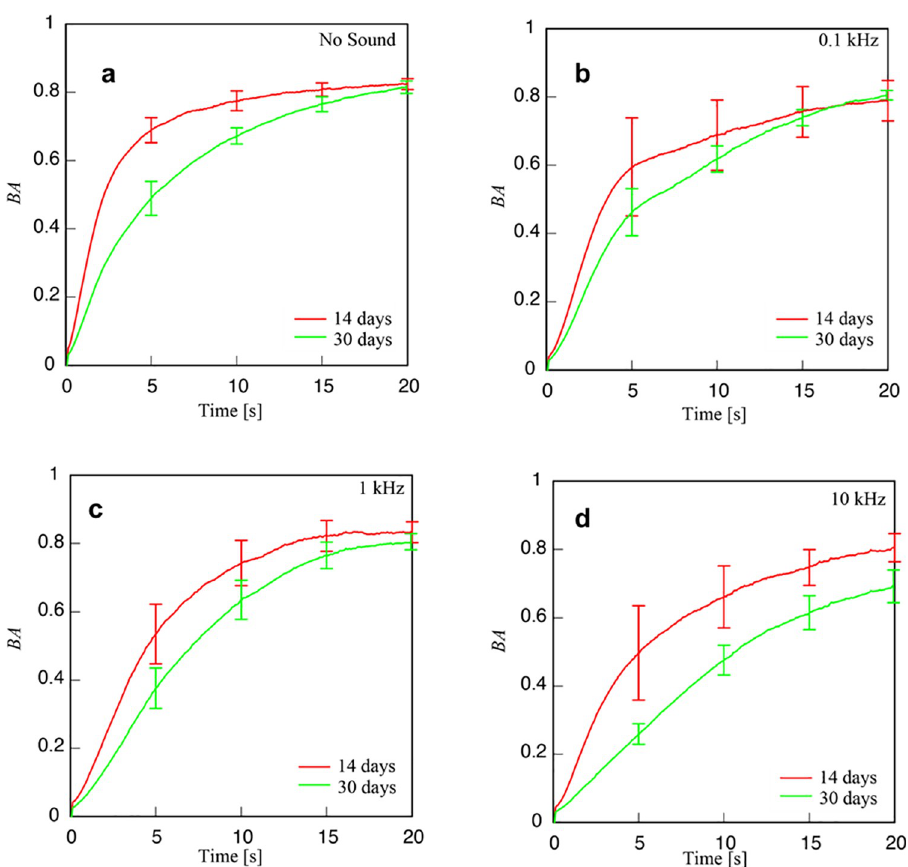
Fig 7. Temporal variation of BA from leaf of an arugula plant under exposure to sounds of different frequencies with (a) control or no sound, (b) 0.1kHz, (c) 1 kHz, and (d) 10 kHz for 14 dap (red) and 30 dap (green).